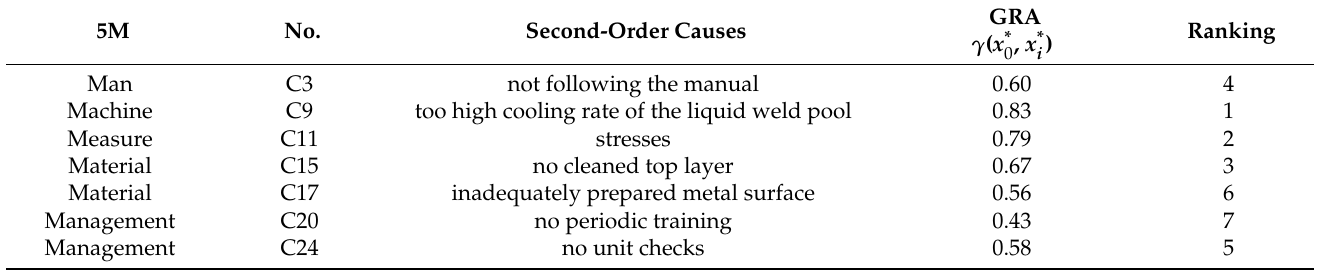
Table 5. Ranking of activities to stabilize the quality of the bearing housing.